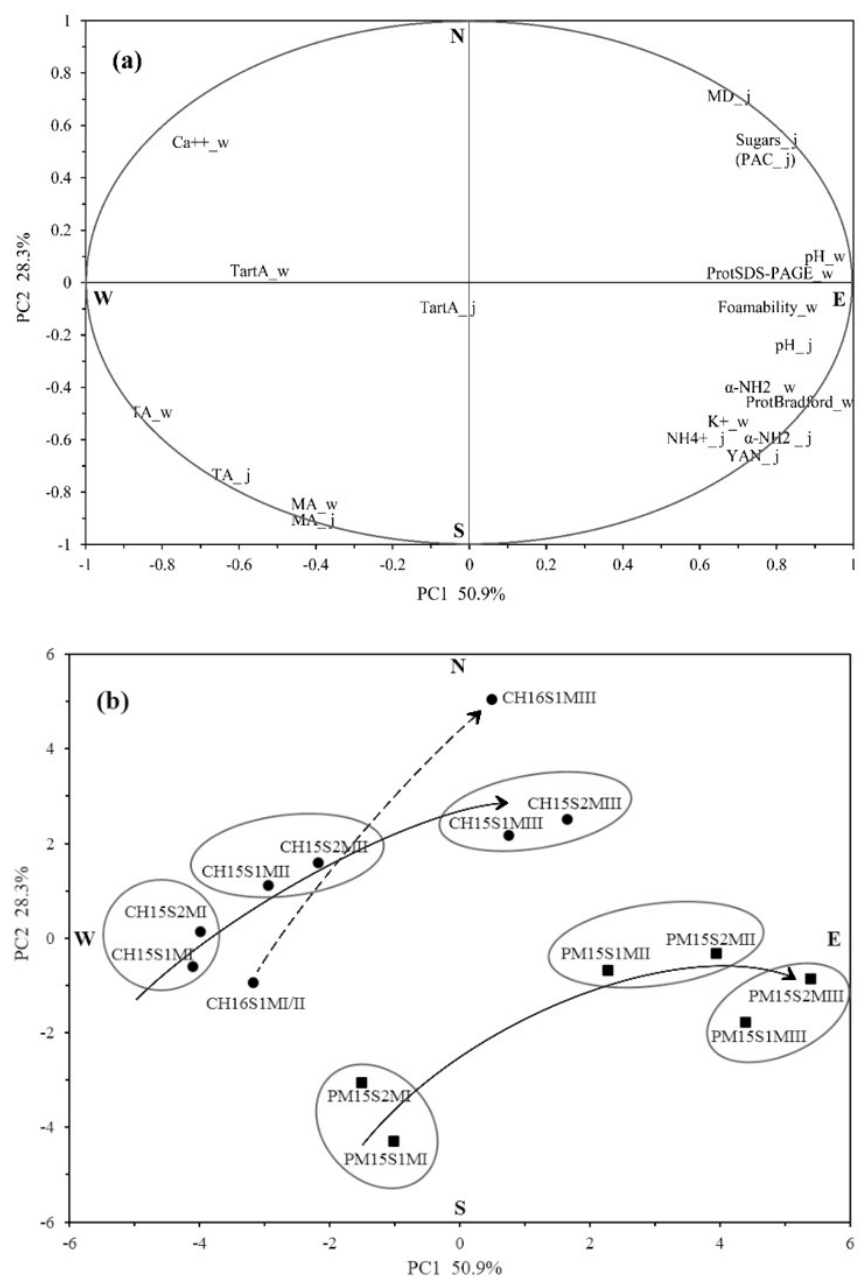
Figure 5. Principle component analysis applied to oenological parameters ( a ) and sample distribution ( b ) for Pinot meunier (PM) and Chardonnay (CH) grape juices and base wines.